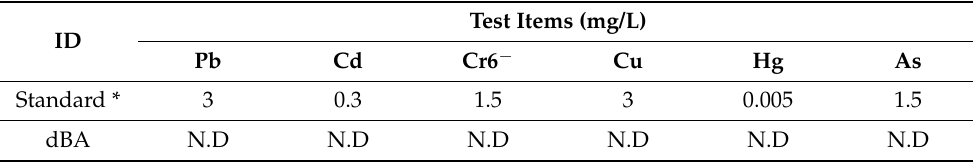
Table 6. Heavy metal content analysis type—I.